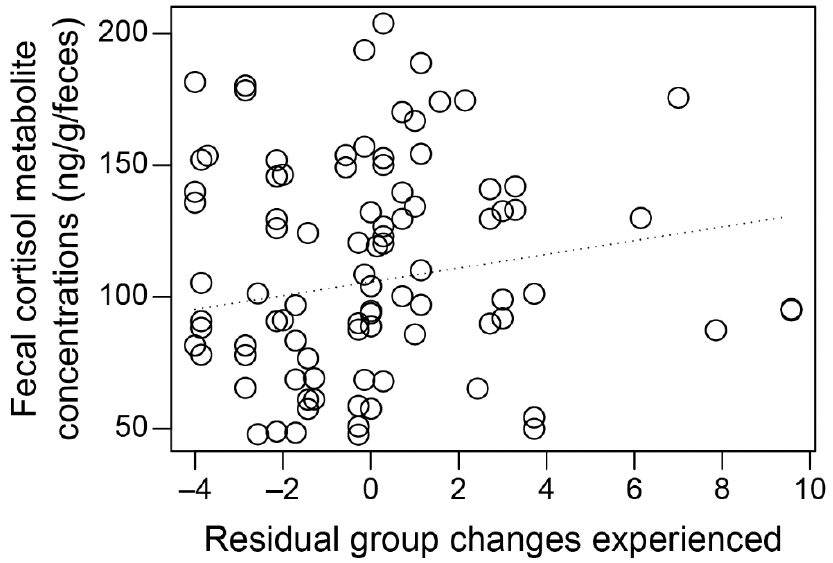
Figure 1. Residual group changes stallions experienced and stallion FCM concentrations. FCM concentrations did not vary with the number of group changes males experienced. Open circles indicate individual fecal samples; dotted line indicates model predictions.